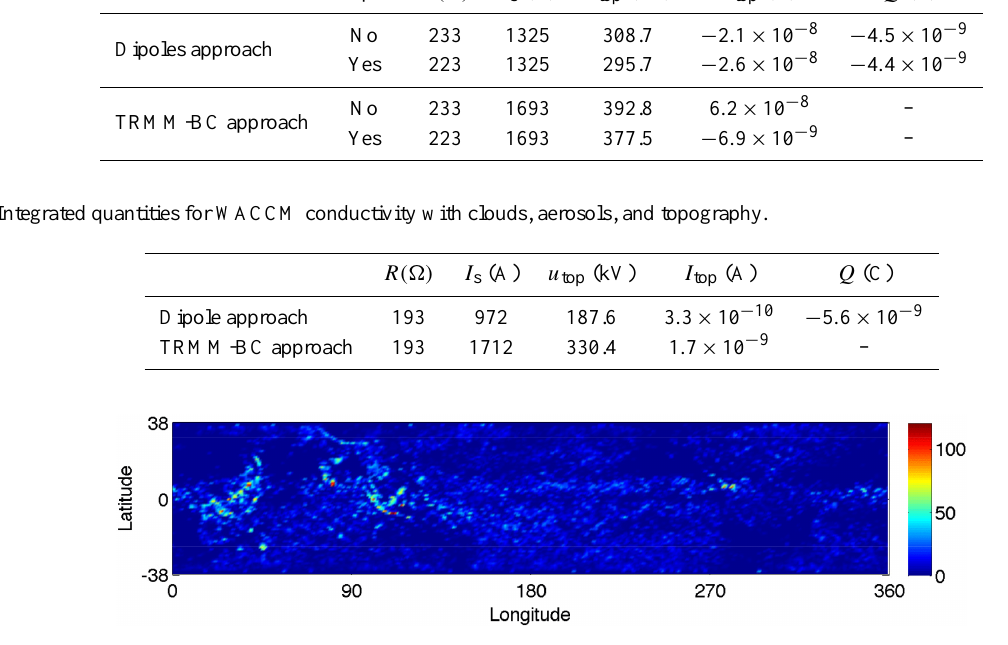
Table 2. Integrated quantities for the exponential conductivity (Eq. 26) using both methods in Sect. 4.6 with and without topography. Topo.